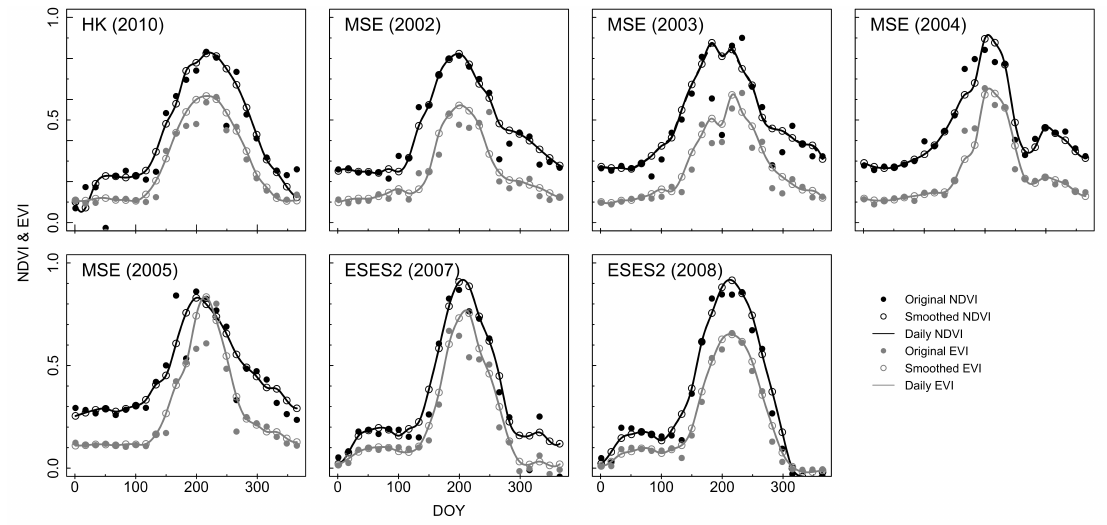
Figure 1. Seasonal variation of MODIS NDVI and EVI at the study sites. Closed circles indicate original NDVI and EVI, open circles indicate smoothed NDVI and EVI by the TIMESAT method, and solid lines indicate estimated daily NDVI and EVI from spline